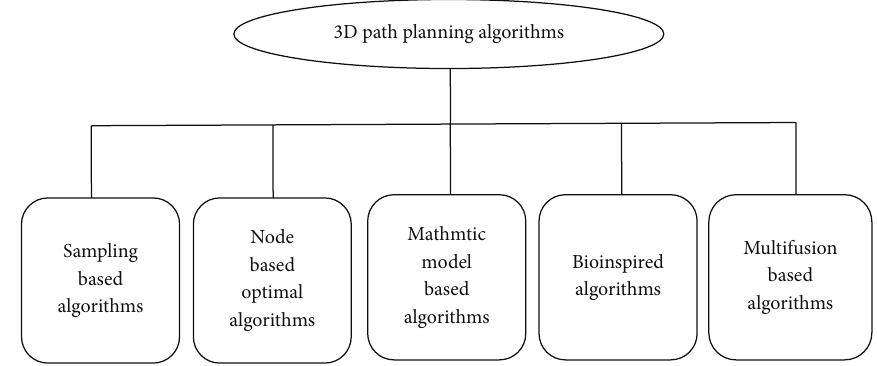
Figure 2: 3D path planning